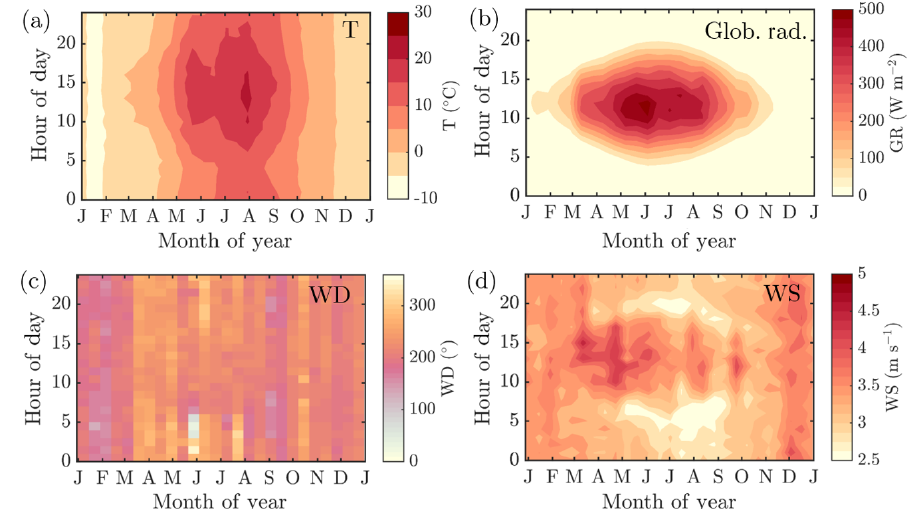
Figure 1. The seasonal evolution of diurnal cycles of ambient temperature measured at 4.2ma.g.l. (a) , global radiation above the forest canopy (b) , wind direction above the forest canopy (c) and wind speed above the forest canopy (d) recorded at SMEAR II station in 2012– 2018. The y axes in the figures represent the local time of day (UTC + 2), and the x axes represent the time of the year. The color scales correspond to the temperature in degrees Celsius, global radiation in Wm − 2 , wind direction in degrees and wind speed in ms − 1 , respectively. Panels (a) , (b) and (d) include interpolation of the 14d × 1h resolution data grid into isolines based on the MATLAB 2017a contourf function. Panel (c) has no interpolation involved due to challenges related to interpolating over a circularly behaving variable. The plot is produced with MATLAB 2017a pcolor